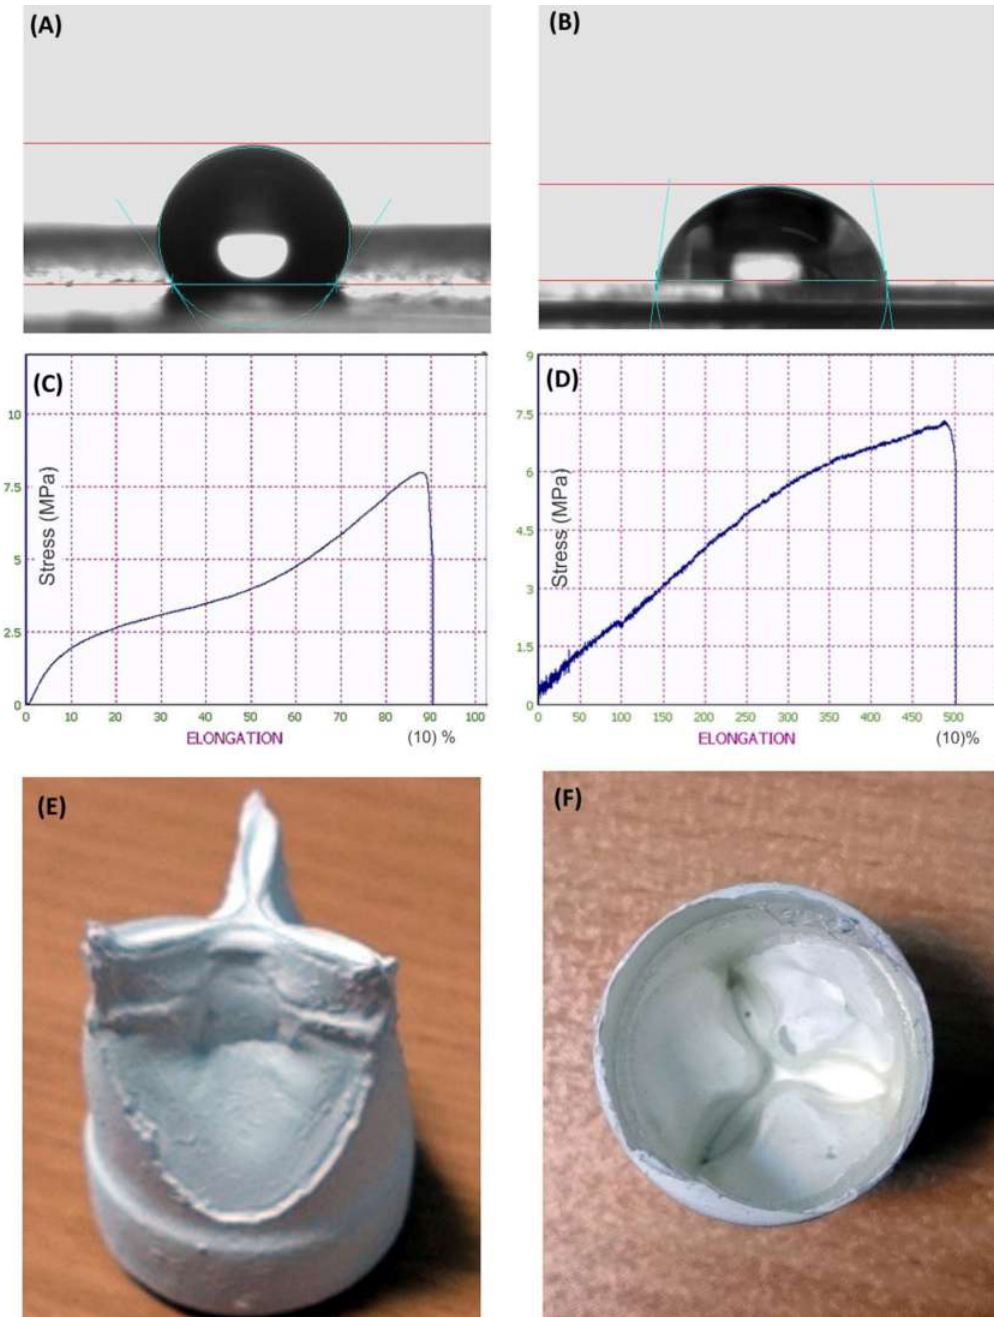
Fig. 2. Contact Angle. (A) Nanofiberous scaffold of polyurethane (B) Film of polyurethane. It is visible that nanofibers were more hydrophobic than film of polyurethane. Tensile mechanical strength of (C) film and (D) fibers of poly urethane. (E) Outside and (F) inside of tissue engineered heart valve which is fabricated by combination of dip coating and electrospinning of